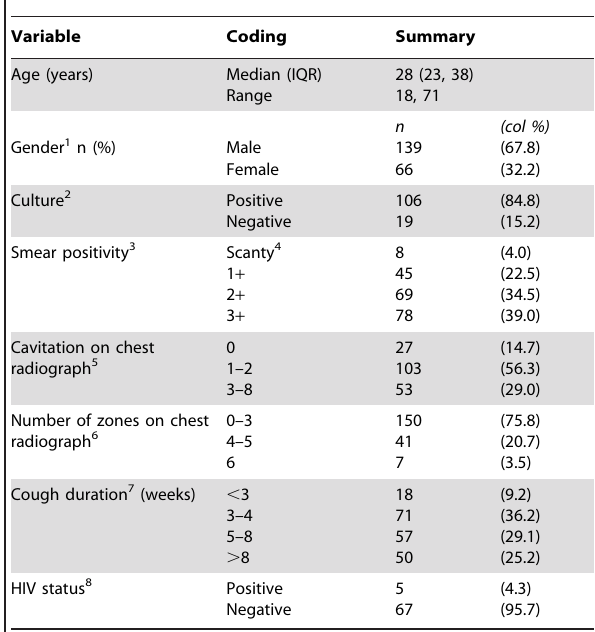
Table 1. Summary of index cases